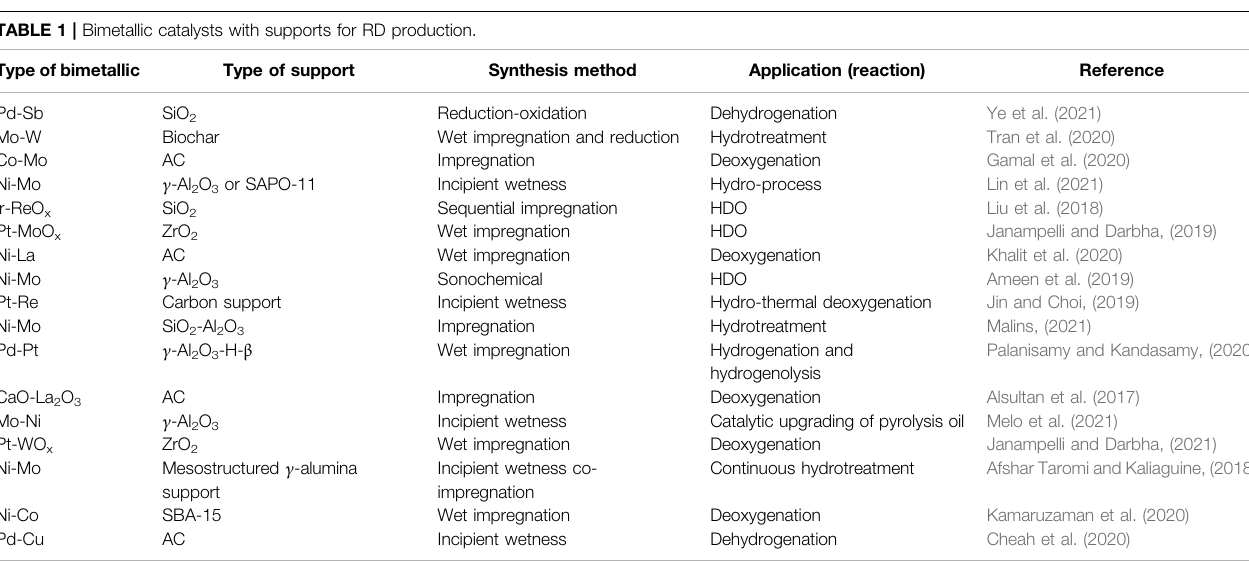
TABLE 1 | Bimetallic catalysts with supports for RD